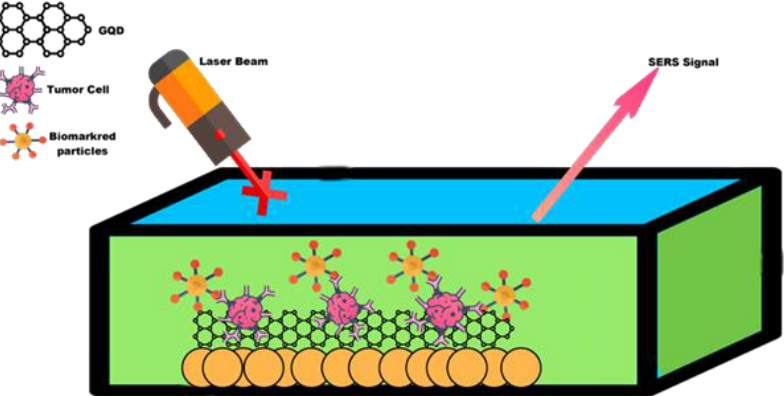
Figure 5. In vivo imaging of SERS-enhanced GQDs for detection of tumours, inflammation and living tissues.